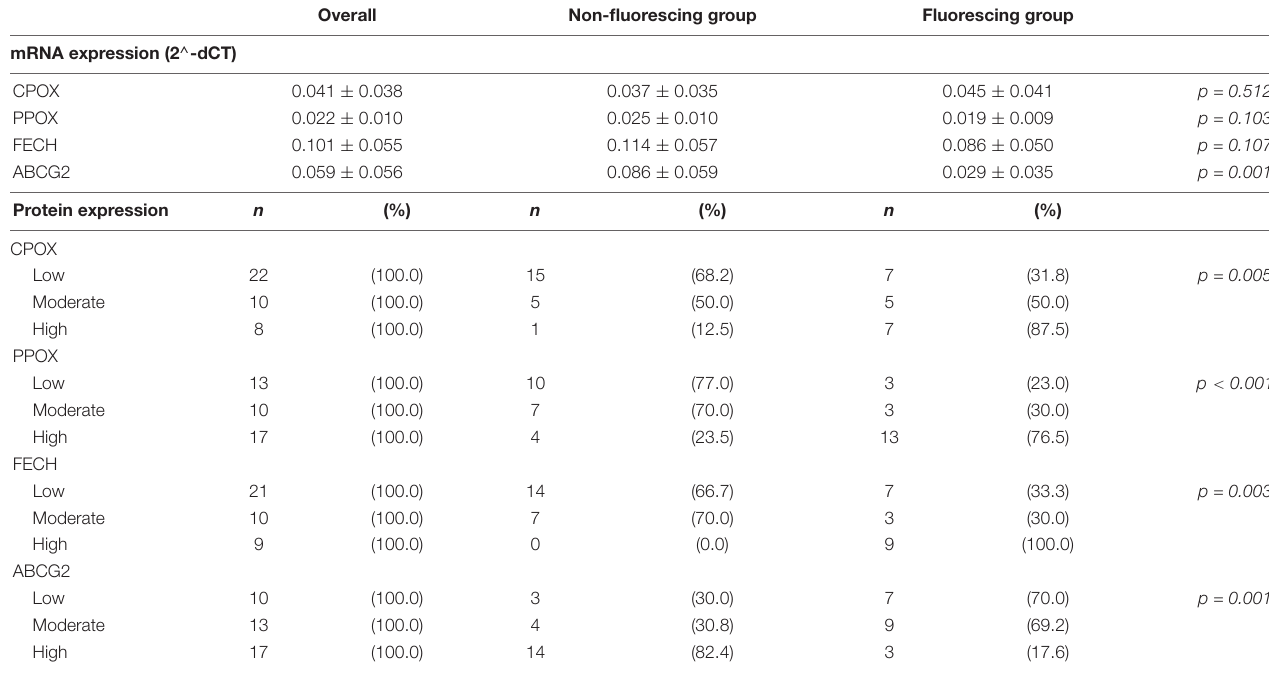
TABLE 2 | mRNA and protein expression